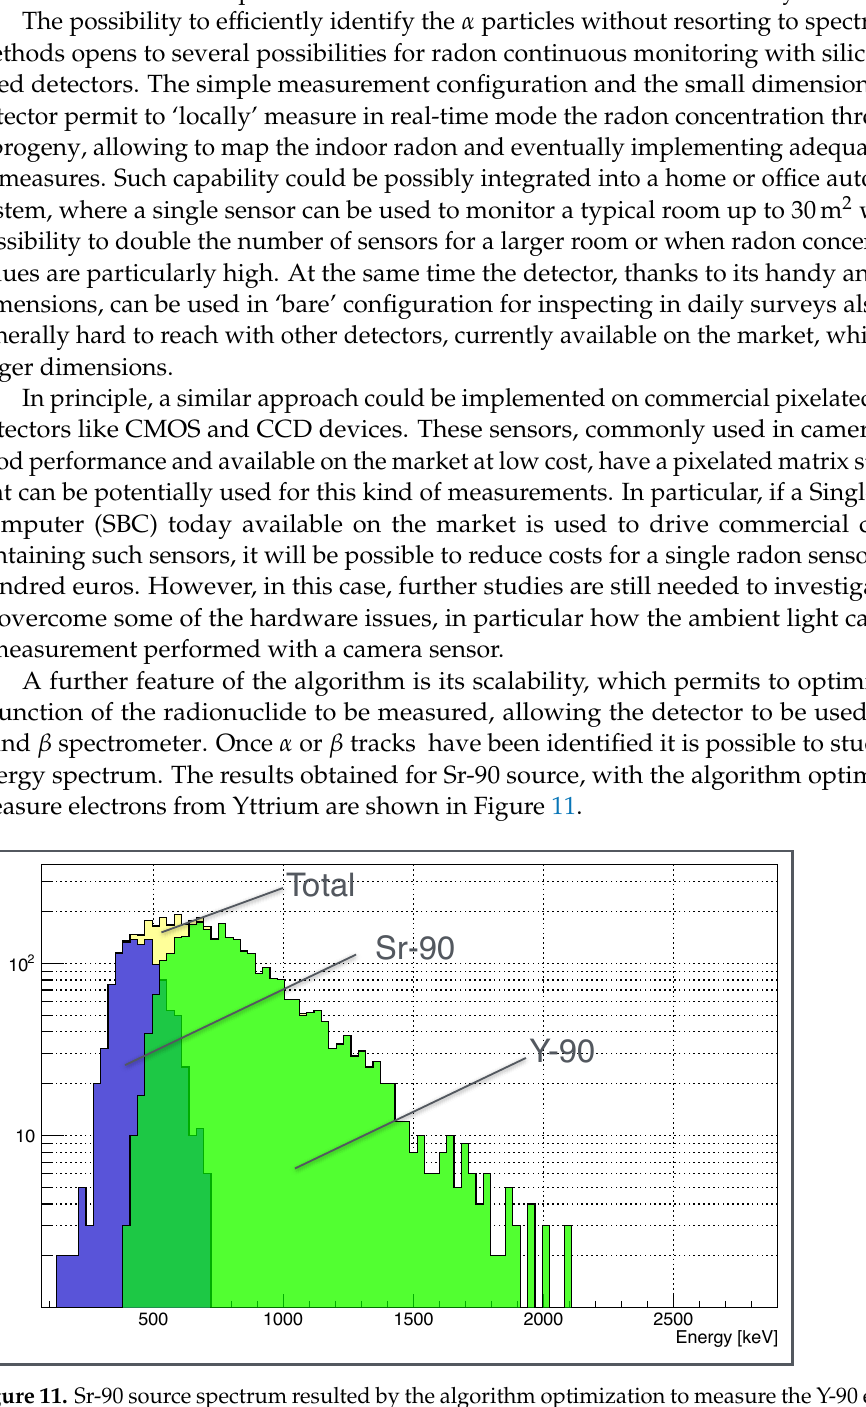
Figure 11. Sr-90 source spectrum resulted by the algorithm optimization to measure the Y-90 electrons. The clusters reconstruction area is increased from 9 × 9 to 13 × 13